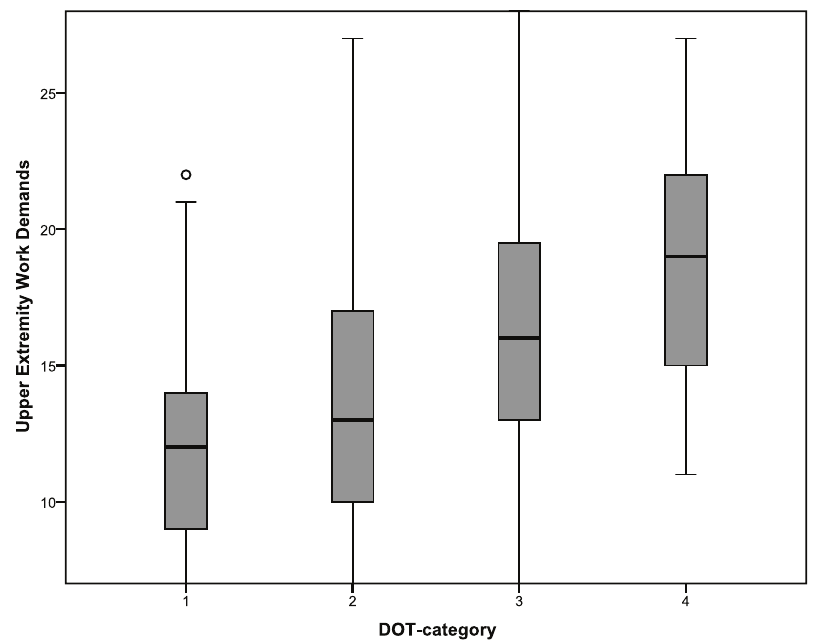
Figure 1. Based on these results, only a weak association could be found between the DOT-categories and UEWD-scores; therefore, hypothesis 1 was not rejected.